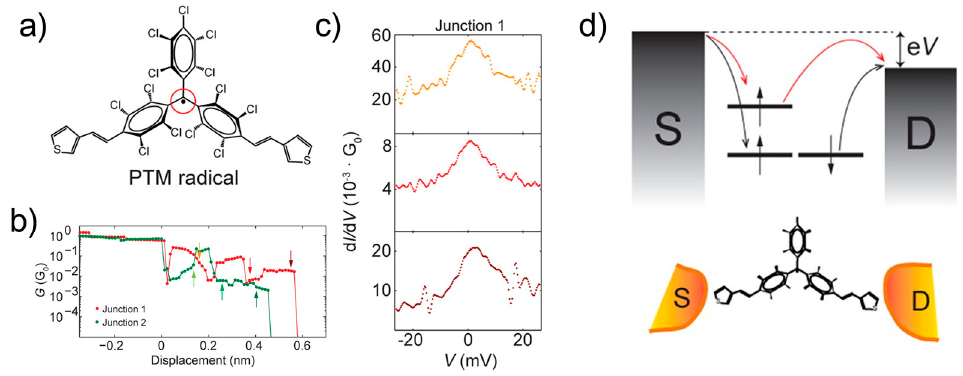
Figure 14. ( a ) Polychlorotriphenylmethyl (PTM) radical molecule. ( b ) Conductance traces for two different PTM molecular junctions. ( c ) dI / dV spectra measured at displacements indicated by the arrows in ( b ). ( d ) Schematic image of the energy levels/orbitals involved in the electron transport through the PTM molecule. Reproduced with permission from [60], copyright Nano Letter Publishing Group 2015.